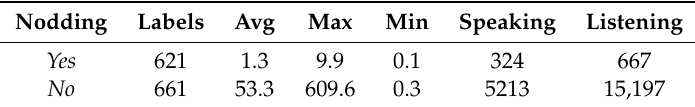
Table 6. Annotation results on the nods of the participants of the data corpus: the columns, “avg,” “max,” and “min” shows the average, maximum, and minimum durations of individual labels in seconds, respectively, and Speaking and Listening are the resulting instance numbers in corresponding models.